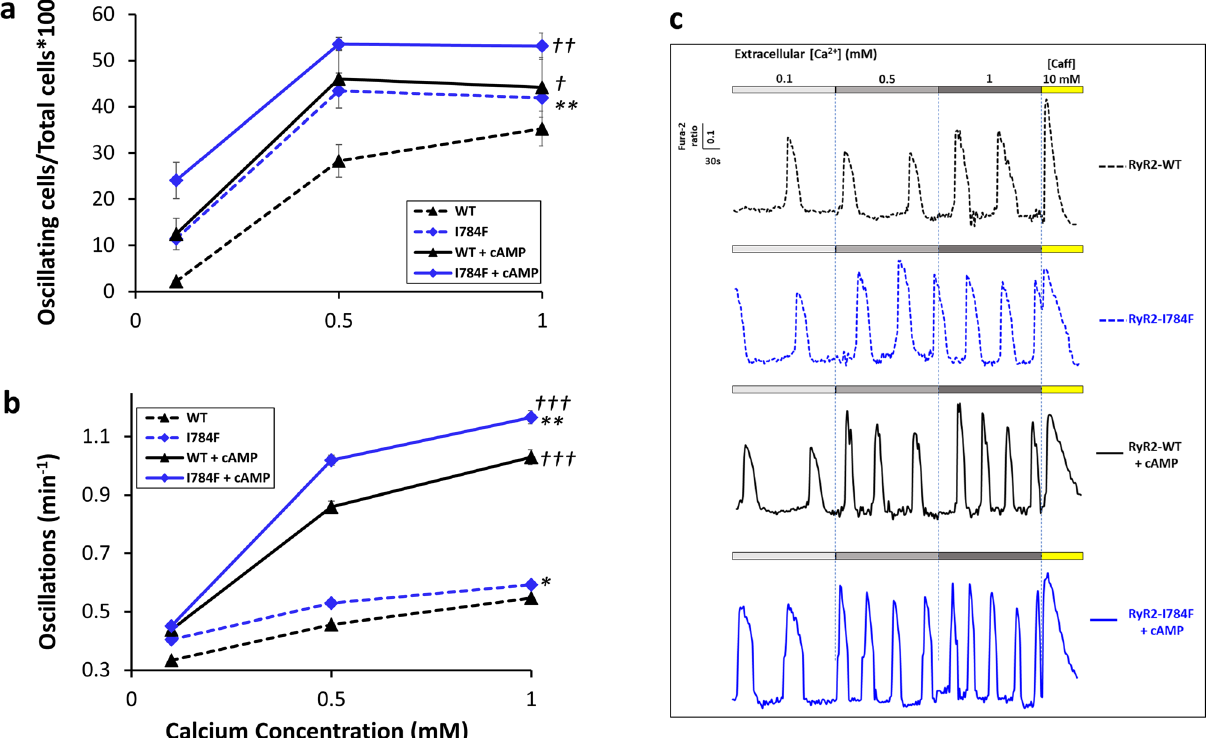
Figure 3. Enhanced Ca 2+ release of RyR2-I784F mutant. HEK293 cells were transfected with eGFP- hRYR2-WT (black symbols) or eGFP- hRYR2-I784F (blue symbols) plasmids for 48 h and loaded with 5 μM Fura-2 for 45 min. Cells were then perfused with KRH buffer at 0.1, 0.5 or 1.0 mM CaCl 2 (dashed lines). Solid lines correspond to the cells treated with cAMP for 20 min prior to the monitoring. ( a ) Percentage of oscillating cells. ( b ) Number of spontaneous Ca 2+ oscillations per minute. ( c ) Representative traces of Ca 2+ release under basal conditions and after cAMP treatment. The total numbers of cells analyzed for Ca 2+ oscillations from three separate experiments under basal conditions were n = 588 for WT cells, and n = 524 for I784F cells; and after cAMP treatment, n = 347 for WT and n = 316 for I784F cells. Data are mean ± SEM. *p ≤ 0.02, **p ≤ 0.001,